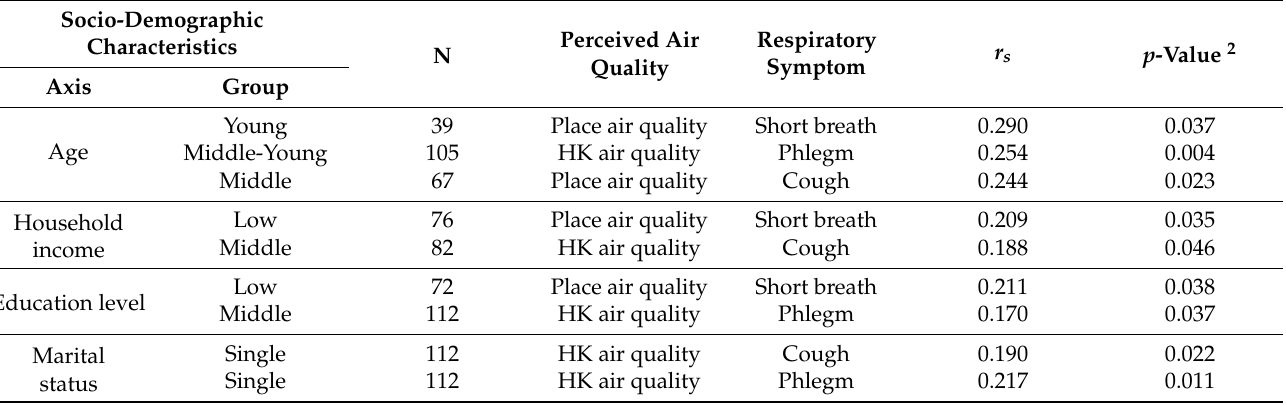
Table 6. The significant Spearman rank correlation coefficients in the categories of age, monthly household income, education level, and marital status 1 .